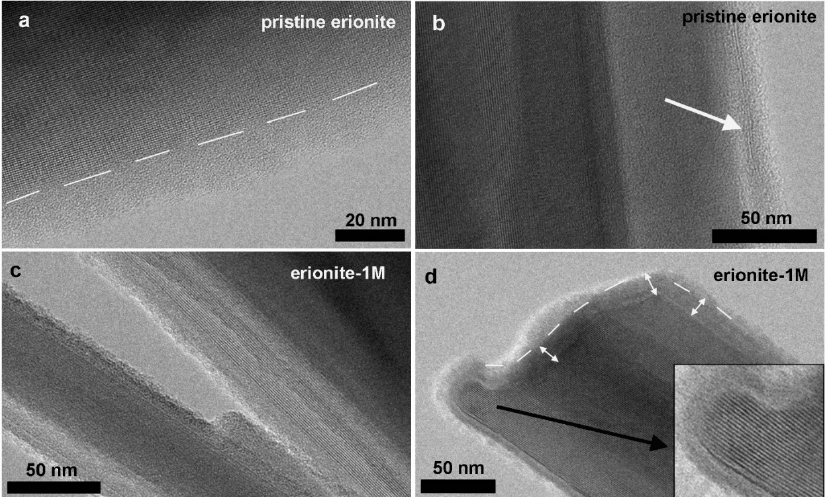
Figure 6. Bright-field TEM images, comparing the edge nanomorphology of pristine and E-1M erionite fibres: ( a ) Pristine erionite fibre edge; dashed line separates the crystalline portion of erionite (characterized by regularly spaced lattice fringes) and the amorphous outer envelope, ~20 nm think. ( b ) Ultrathin flakes, consisting of two-three irregular lattice fringes (white arrow), hosted within the outer amorphous envelope. ( c ) E-1M erionite fibres; the amorphous envelope appears to be wider and with a more irregular and lobate pattern. ( d ) Termination of an E-1M erionite fibre, showing lobate crystal edges (enlarged view in the inset). The outer envelope is amorphous, but it appears associated with a further inner damaged layer (double-terminated white arrows).